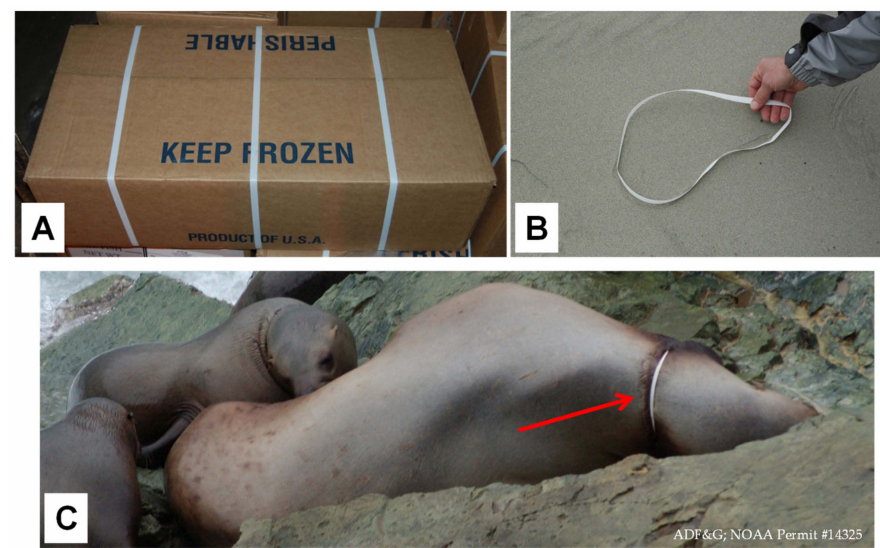
Figure 4. Examples of ( A ) plastic packing bands on fish bait box, ( B ) plastic packing band washed up on a beach in Newport, Oregon, and ( C ) adult female Steller sea lion with plastic packing band around neck (indicated by red arrow).